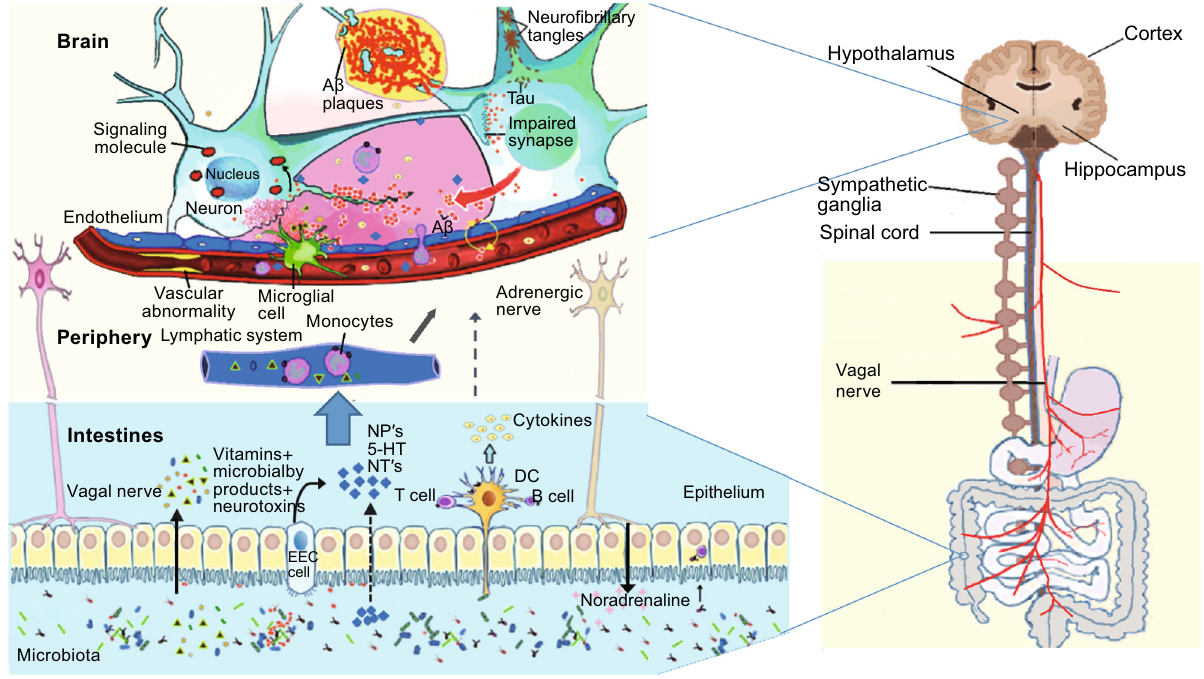
Figure 1. Schematic of some key players in the pathogenesis of AD. The gut microbiota regulation of neuro-in fl ammation and the hypothalamic – pituitary – adrenal (HPA) axis activity and may lead to AD. The bacterial products that gain access to the brain through the bloodstream and the area postrema, via cytokine release from mucosal immune cells, through the release of gut hormones such as 5-HT from EEC cells, or via afferent neural pathways, including the vagal nerve. NP: Neuropeptide; NT: Neurotransmitter; 5-HT: 5-hydroxytryptamine; DC: Dendritic cell; EEC: Enteroendocrine cell; A β : amyloid beta protein; AD: Alzheimer ’ s